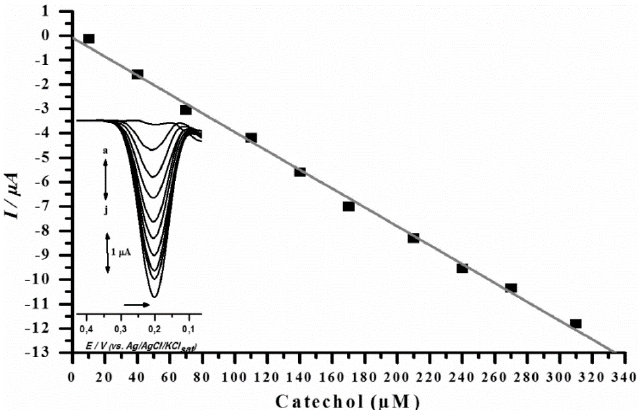
Figure 3. Analytical curve and DPVs obtained through CP-Jen100 at different catechol concentrations in PBS 0.1 M (pH 7.0).